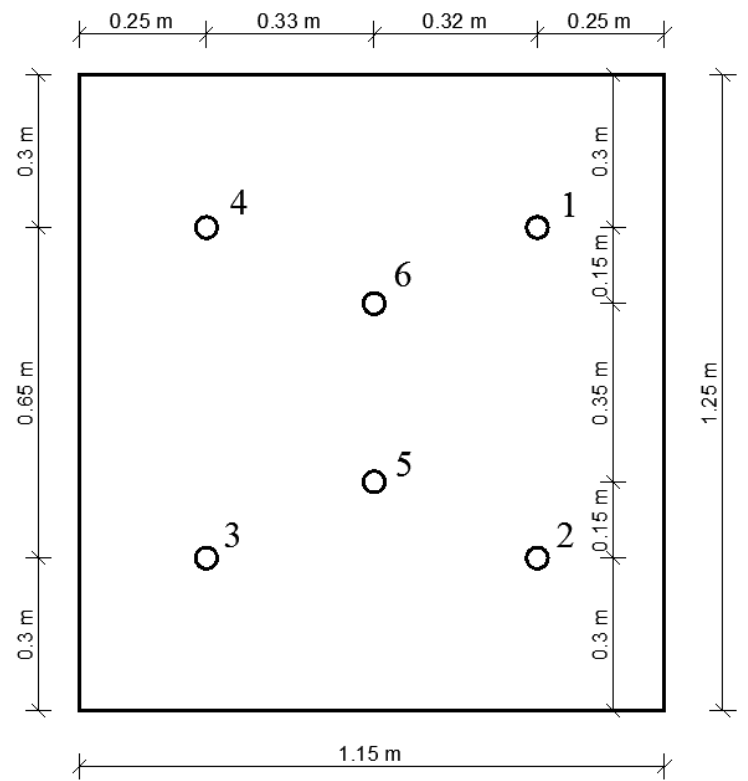
Figure 3. Layout of pile models, 0.8 m embedded in the soil, in the box.